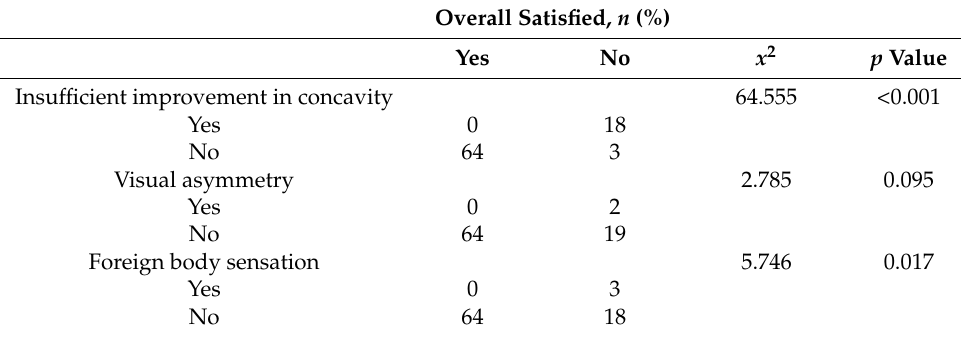
Table 3. Subgroup analysis (with a x 2 test) of patient